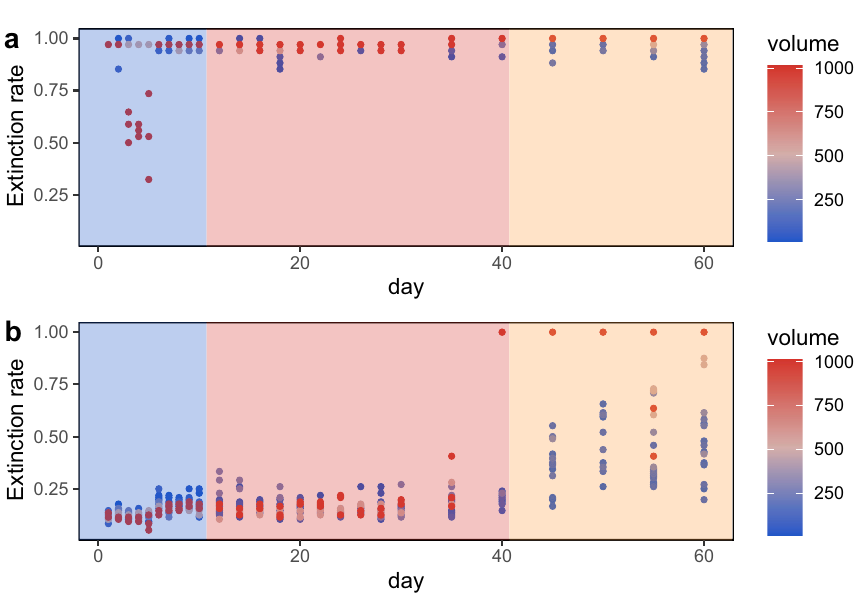
Figure 6. ( a ) Extinction rate of non-acid-producing bacteria. ( b ) Extinction rate of acid-producing bacteria. The colour depth of the dots represents the volume of the microcosm system, increasing in volume from blue to red. The blue background represents Phase 1, red represents Phase 2, and yellow represents Phase